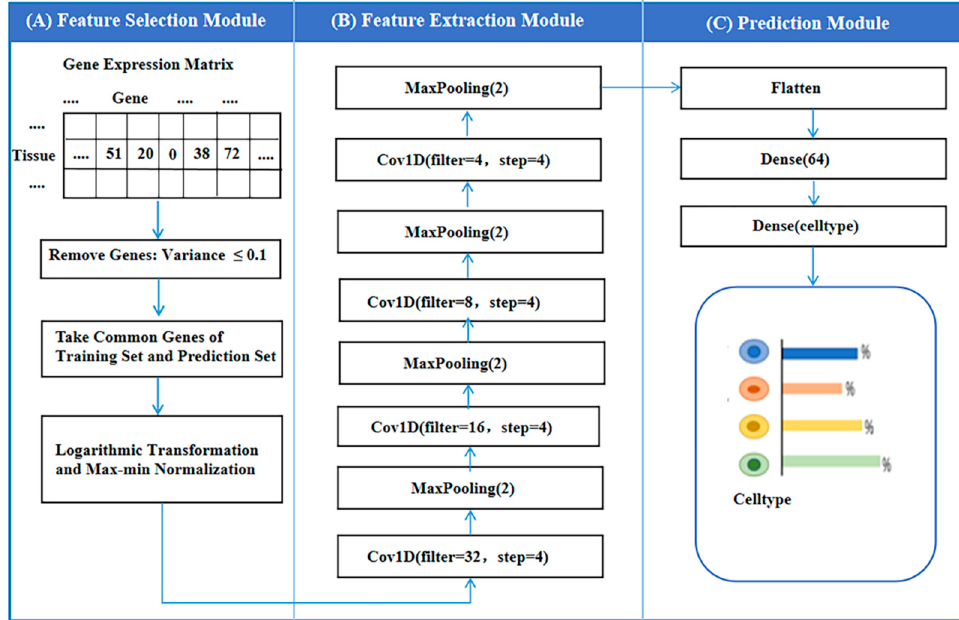
Figure 1. The structure of Autoptcr. ( A ) The feature selection module can screen the genes and transform data. ( B ) The feature extraction module extracts gene expression intrinsic information using convolution and pooling. ( C ) The prediction module predicts the cell ratio of the tissue.